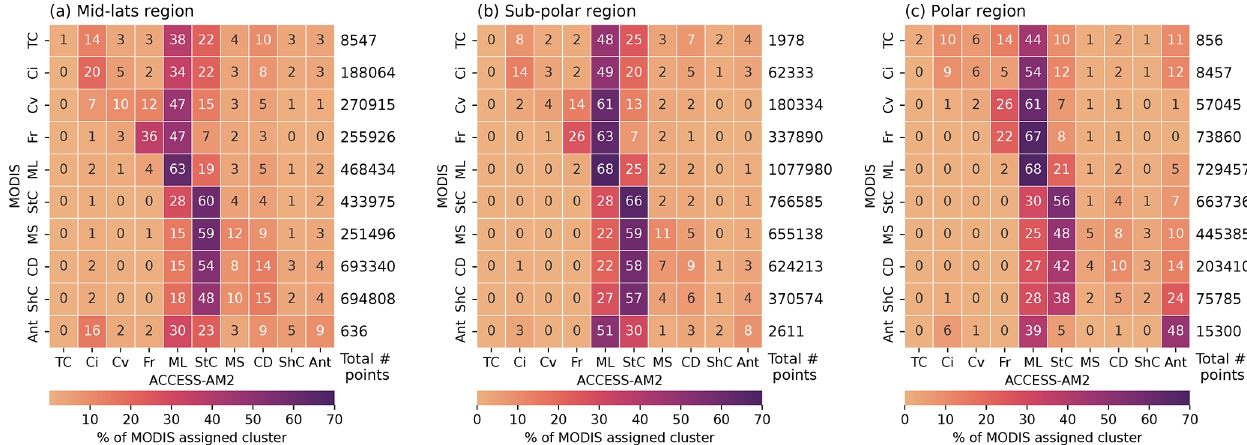
Figure 7. Confusion matrices for each region, (a) mid-latitudes, (b) sub-polar and (c) polar, showing the MODIS cluster assignment on the y axis and the ACCESS-AM2 cluster assignment on the x axis (thin cirrus, TC; cirrus, Ci; convective, Cv; frontal, Fr; mid-level, ML; stratocumulus, StC; marine stratiform, MS; cloud decks, CD; shallow cumulus, ShC; Antarctic, Ant). The colours (and inset text) represent the proportion of points assigned to each MODIS cluster (e.g. sum to 100 along the x axis). The text on the right hand side indicates the number of points (in time and space) that make up these statistics for each MODIS